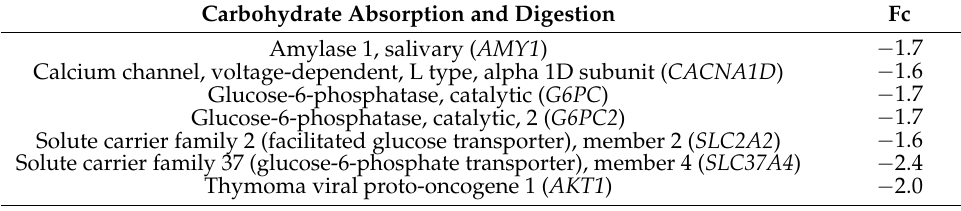
Table 5. Cont. Carbohydrate Absorption and Digestion